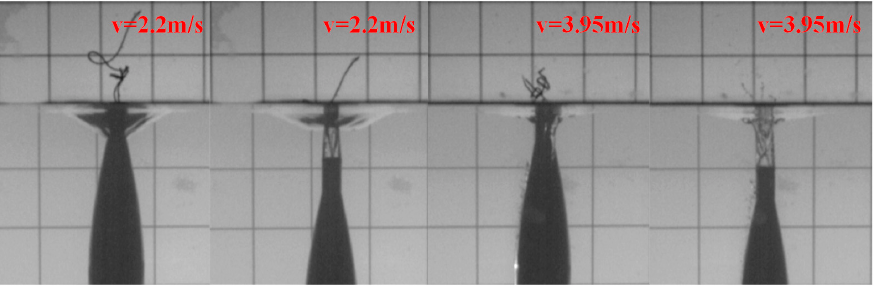
Figure 21. Schematic diagram of the tail cavity.